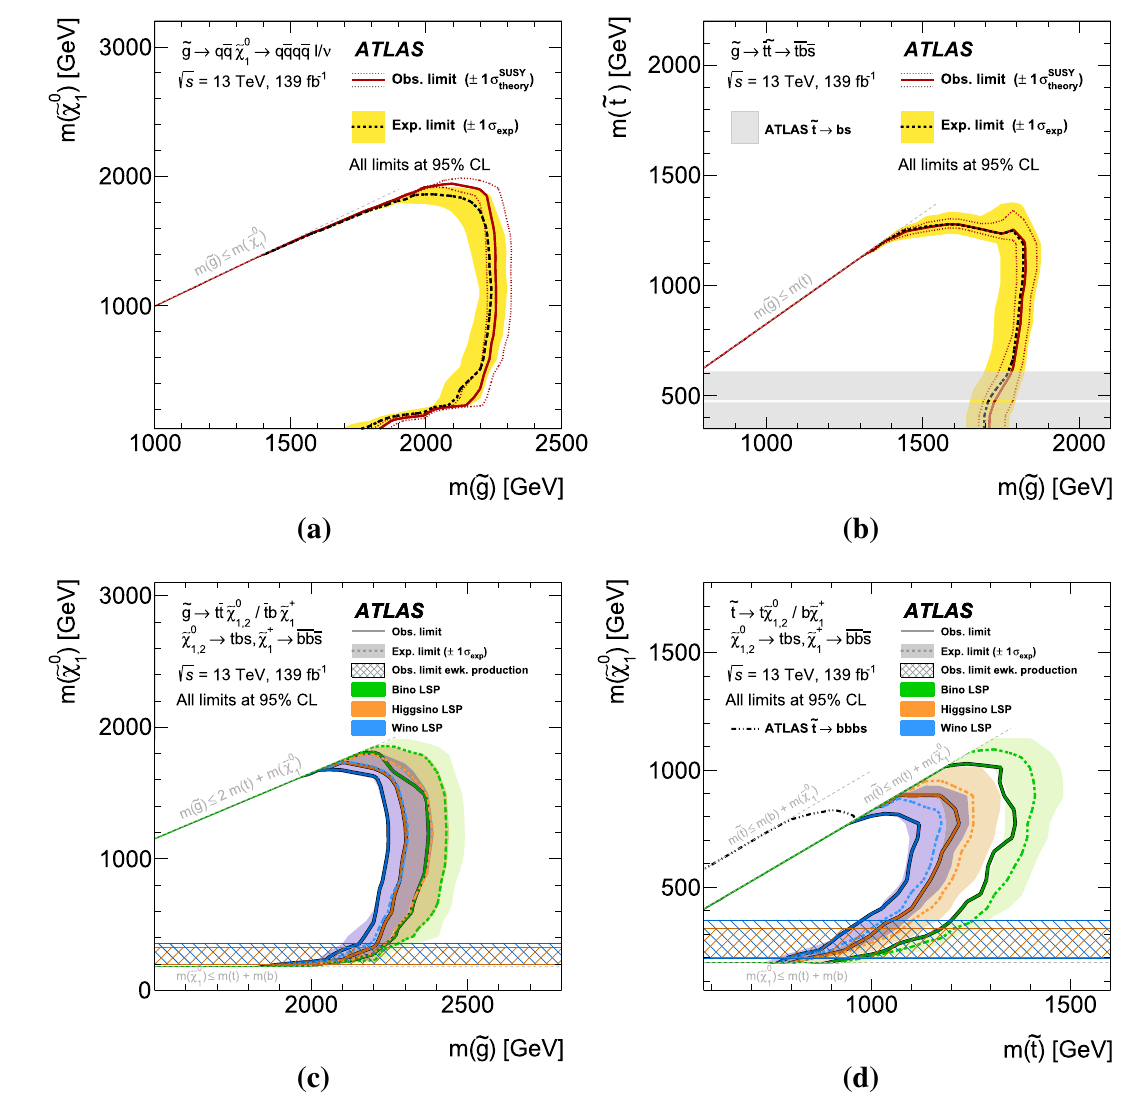
Fig. 9 Observed and expected exclusion contours for the RPV models tainty. All limits are computed at 95% CL. The diagonal line indicates → the kinematic limit for the decays in each specified scenario. The limits with strong production. The results are shown for a ˜ g → q ¯ q ˜ χ 0 1 → t ¯ ttbs and d stop pair on direct electroweakino production obtained with the EWK analysis q ¯ qq ¯ q (cid:3)/ν , b ˜ g → ¯ t ˜ t → ¯ t ¯ b ¯ s , c ˜ g → t ¯ t ˜ χ 0 1 , 2 are displayed as horizontal hatched bands in c and d . When relevant, production. The contours of the band around the expected limit are the ± 1 σ variations, including all uncertainties. The dotted lines around the the limit on the stop mass from Refs. [23,27] is also shown. A small range in stop mass between 460 and 470 GeV is not excluded by the observed limit illustrate the change in the observed limit as the nominal search for ˜ t → bs signal cross-section is scaled up and down by the theoretical uncer-